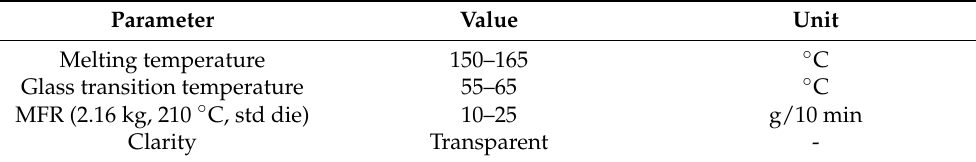
Parameter Melting